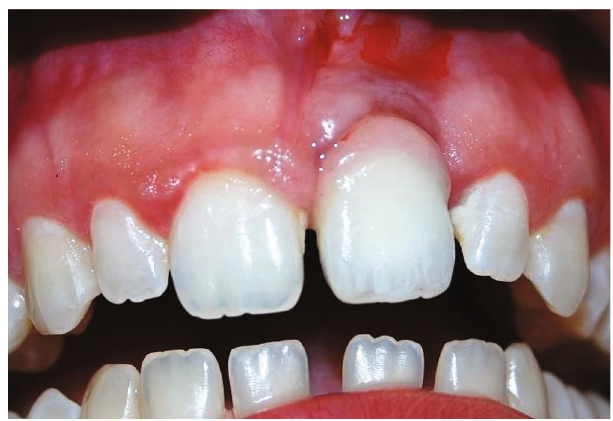
Figure 1: The patient came to us with a prosthetic rehabilitation implant for the 21 that did not satisfy any functional or aesthetic parameter.